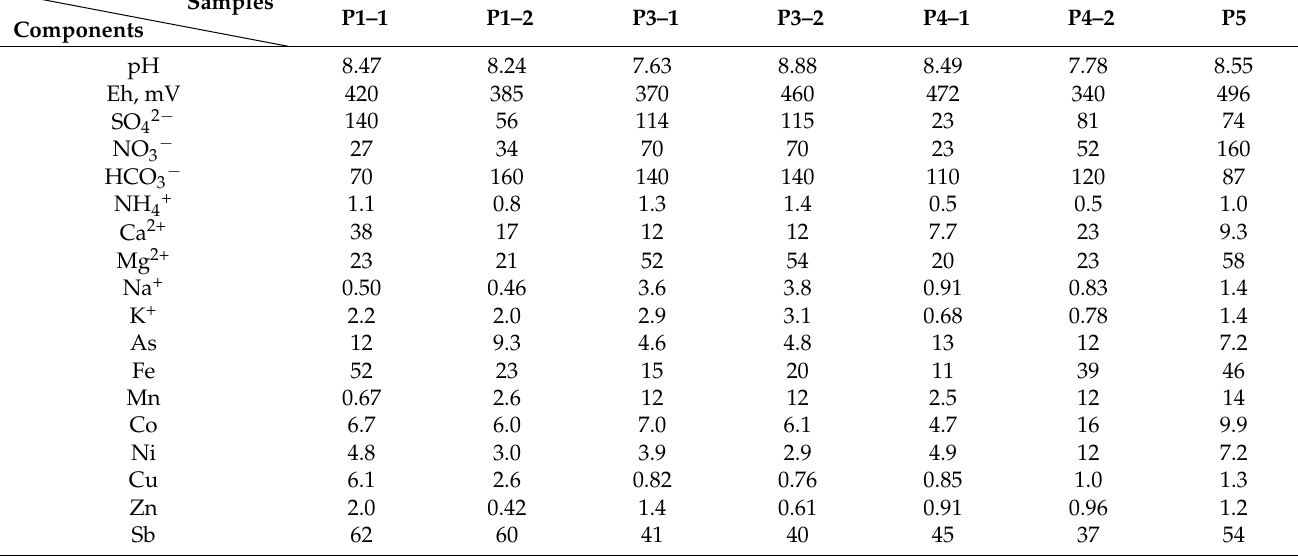
Table 9. Composition of water in the surface reservoirs SO 42 − –As in mg/L and Fe–Sb in µ